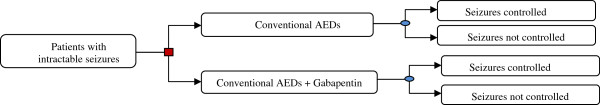
Sample of model used to compare the effectiveness of adding-on Gabapentin to conventional regimen.